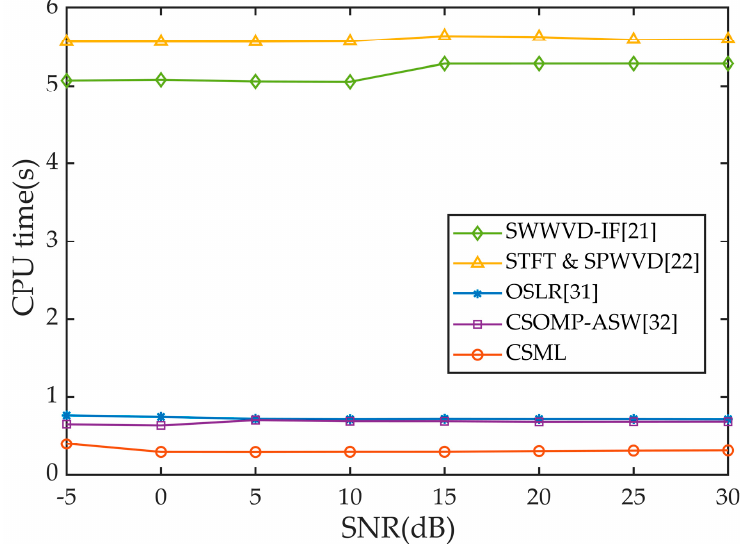
Figure 12. CPU time consumed by the frequency estimation process of the five algorithms under different SNR conditions. Table 3. The minimum SNR for each algorithm to achieve 100% frequency estimation accuracy and the average CPU time consumed by each algorithm.